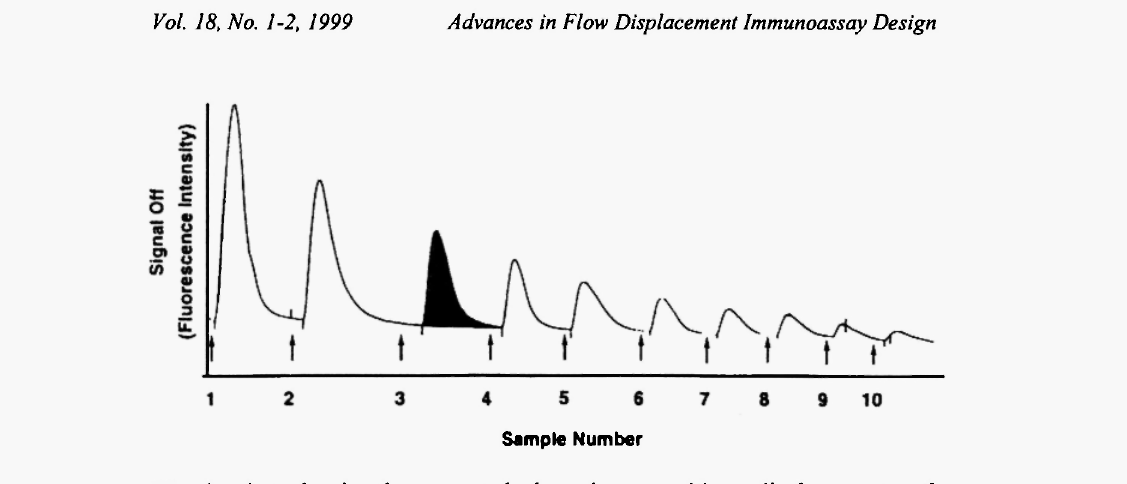
Fig. 4: Actual signal generated by the repetitive displacement of fluorescein-labeled benzoylecgonine utilizing the flow immunoassay at a flow rate of 1 mL/min. The plot illustrates the column depletion which occurs upon repeated injections of highly concentrated analyte solutions. The concentration was the same for all injections in this case. Total peak areas as shown by the shaded example are used for quantitative